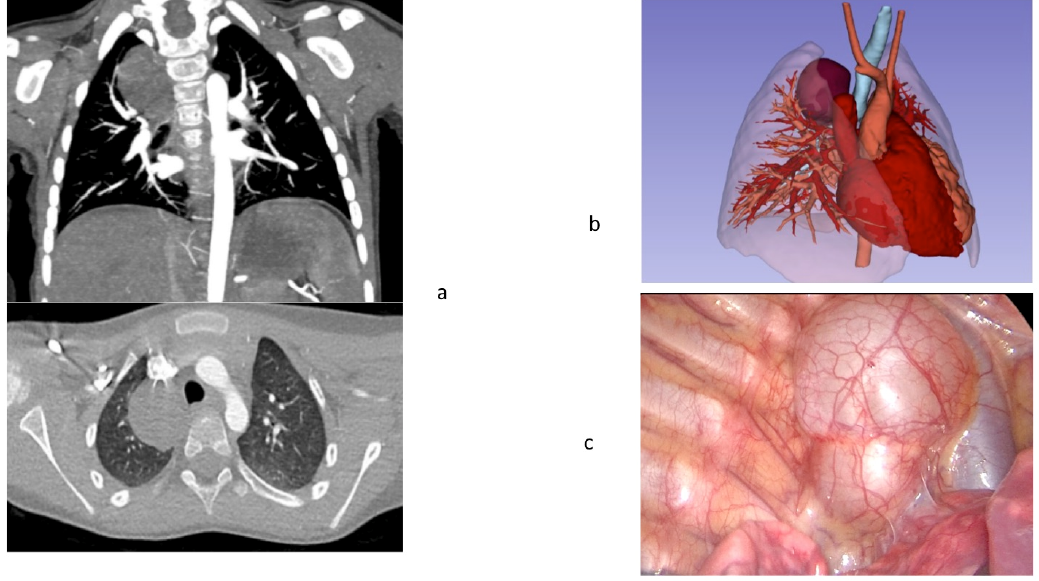
Figure 3. Malformation in patient 2. Panel a , Preoperative anatomy of bronchogenic cyst; Panel b , simulation of thoracoscopic approach; Panel b, Virtual Reality HMD set-up is equipped in the theatre just before proceeding surgery; Panel c, thoracoscopic view of the cyst.